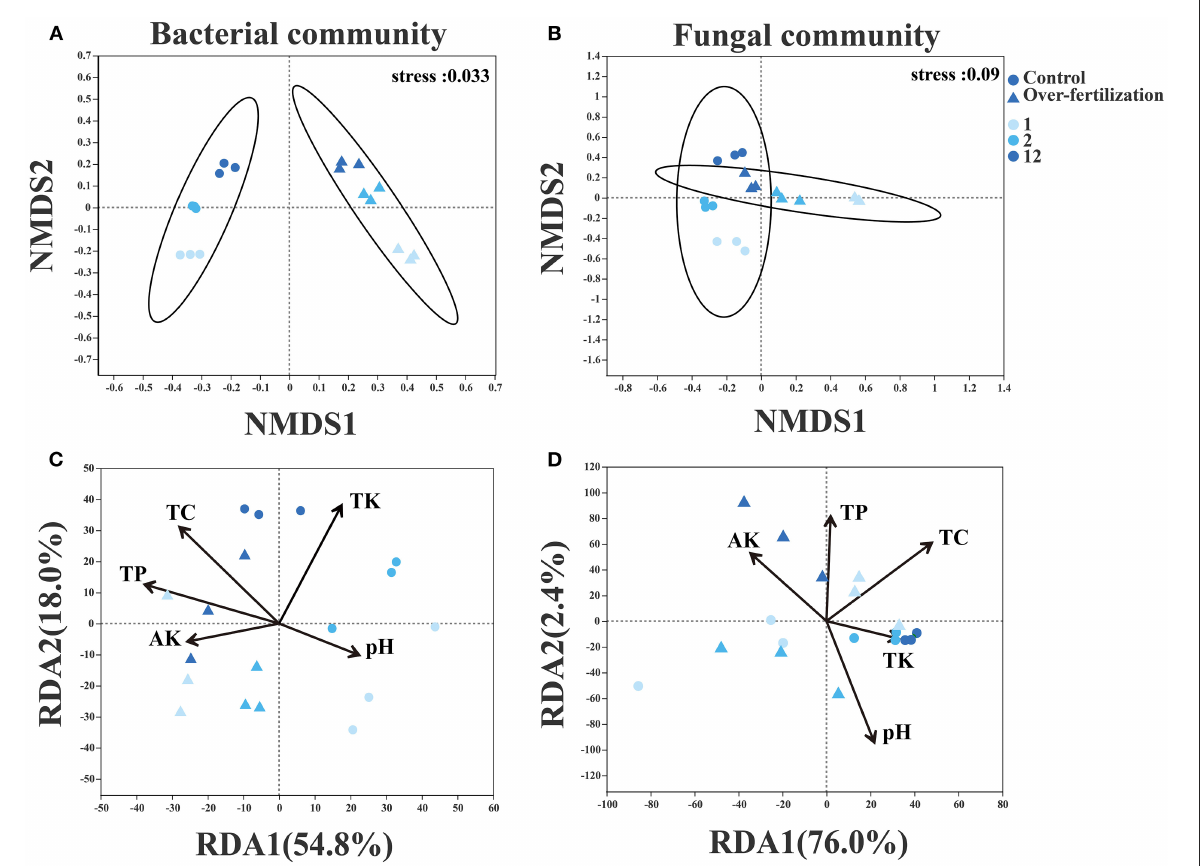
FIGURE4 Effects of fertilization on microbial community composition and structure under tomato cropping. (A) The variations of bacterial NMDS under different treatments. (B) The variations of fungal NMDS under different treatments. (C) The variations of bacterial RDA under different treatments. (D) The variations of fungal RDA under different treatments. Variance inflation factors (VIFs) were used to detect multicollinearity, and factors with VIFs under 10 were retained. TC, total carbon; TP, total phosphorous; TK, total potassium; AK, available potassium.